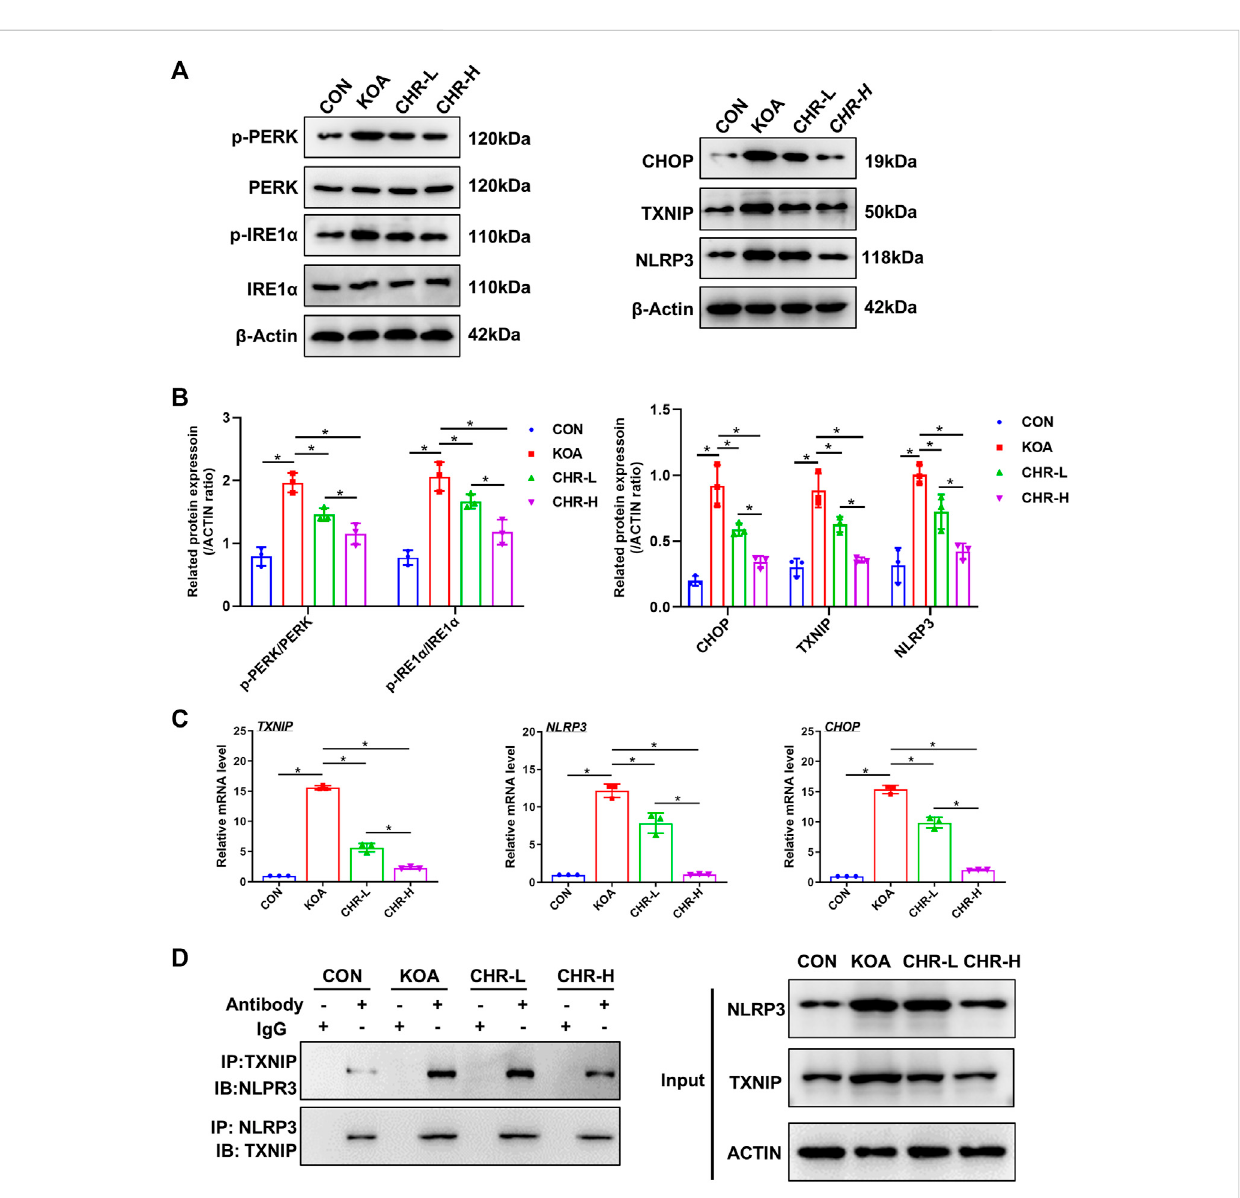
CHR inhibits endoplasmic reticulum stress and TXNIP-NLRP3 interactions in TGF- β -induced SFs. (A) The protein levels of p-PERK/PERK, p-IRE1 α / IRE1 α , CHOP, TXNIP and NLRP3 were determined. (B) The levels of these proteins in the CON, KOA, CHR-L and CHR-H groups. (C) Real-time PCR analysis of TXNIP, NLRP3 and CHOP. (D) Co-IP was used to detect the physiological interaction between TXNIP and NLRP3. IB: immunoblot; IP: immunoprecipitation. n = 3 per group. The data in this fi gure are presented as the mean ± standard deviation, and statistical signi fi cance was determined with one-way ANOVA followed by Tukey ’ s post hoc analysis. p p <